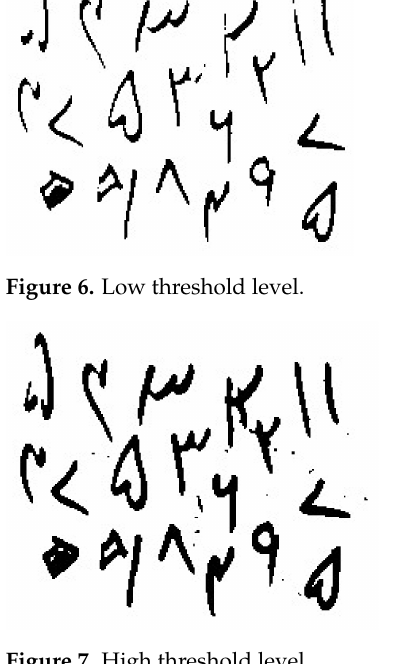
Figure 7. High threshold level.